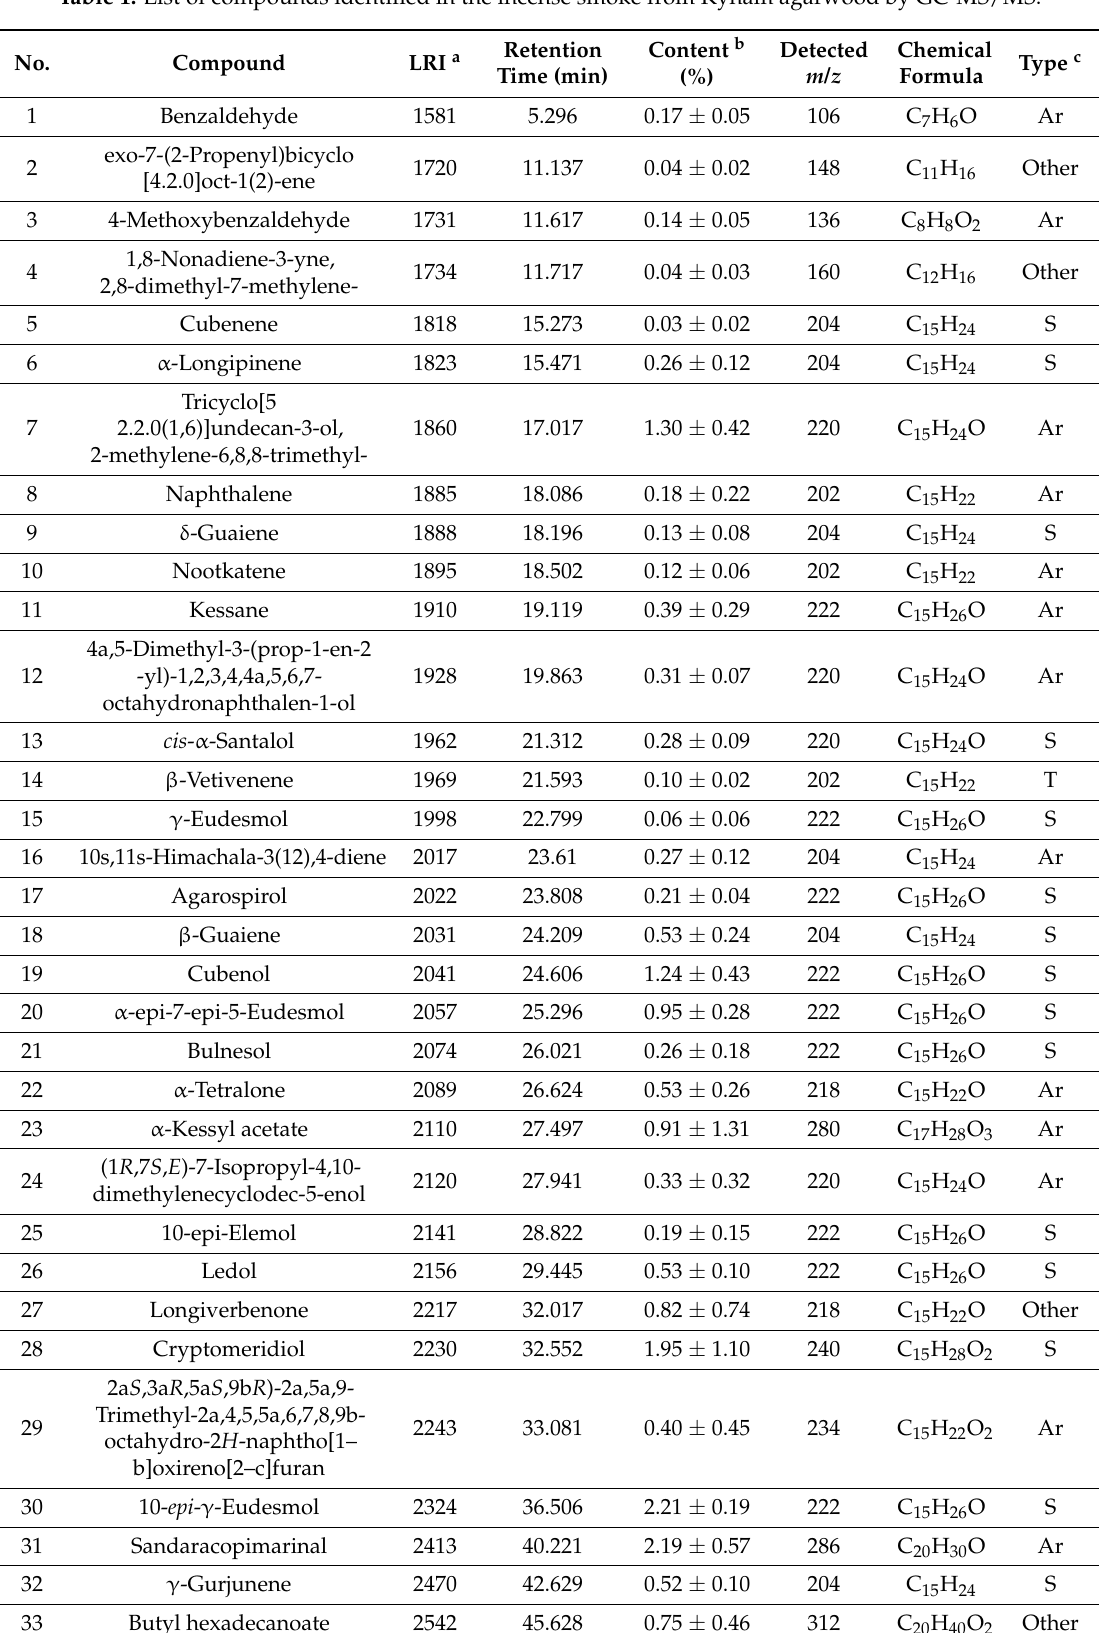
Table 1. List of compounds identified in the incense smoke from Kynam agarwood by